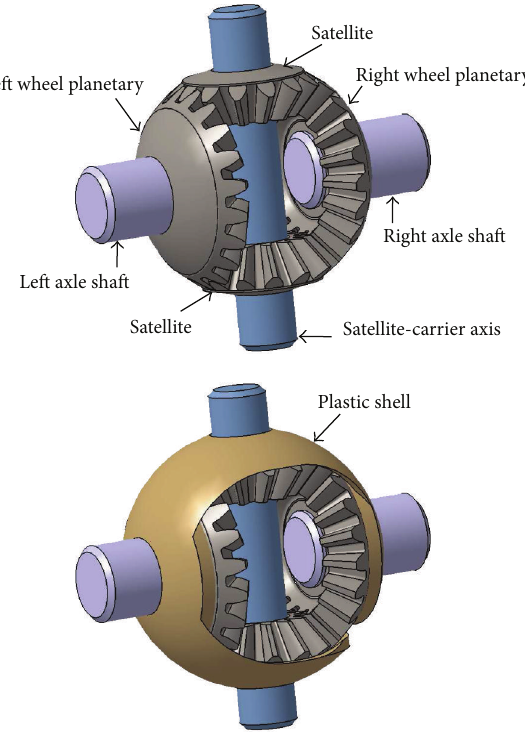
Figure 3: Components of a differential gearbox: two planetary bevel pinions, two satellite bevel pinions with their shaft and the plastic shell.